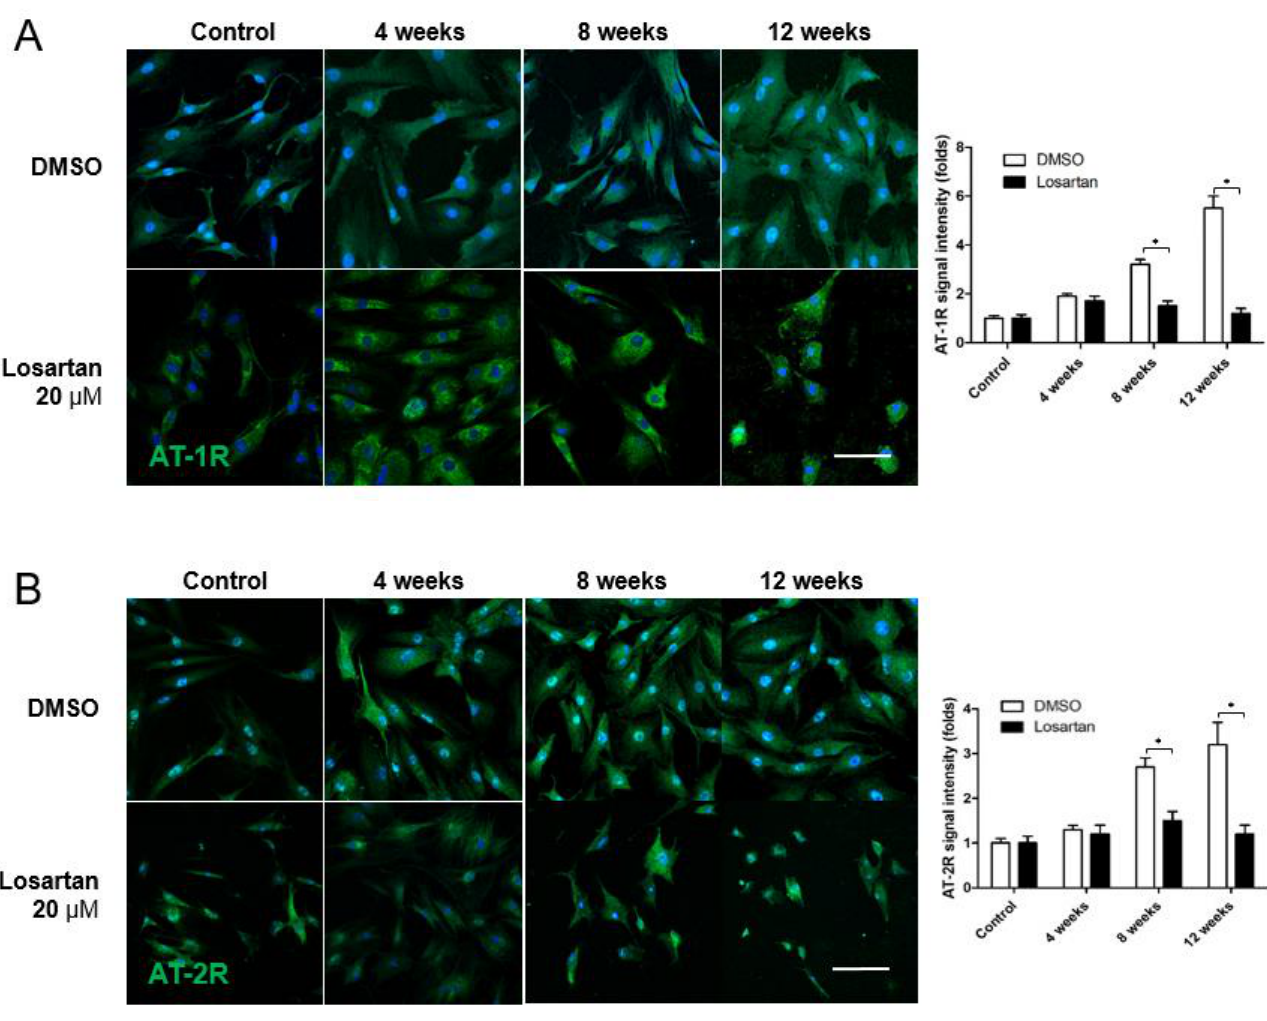
Figure 5. ( A , B ) Immunocytochemical staining of AT-1R and AT-2R. AT-1R and AT-2R expression showed gradual increase in the cultured primary scleral fibroblasts on immunocytochemistry 4, 8, and 12 weeks after systemic hypotension. Applying losartan 20 μM significantly decreased the expression of the AT-1R and AT-2R 4, 8, and 12 weeks after systemic hypotension. Scale bar = 200 μm. * p < 0.05 compared to the control.